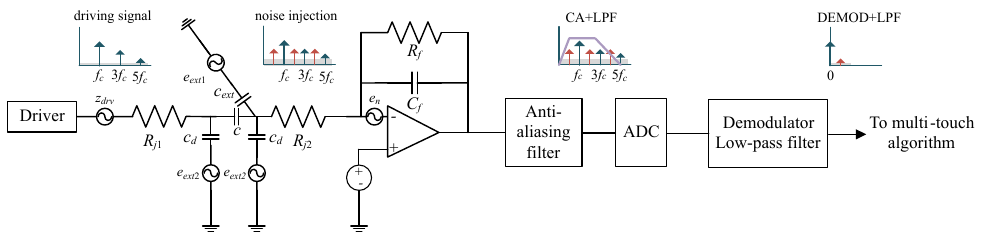
Figure 2. Signal processing flow and possible noise components.